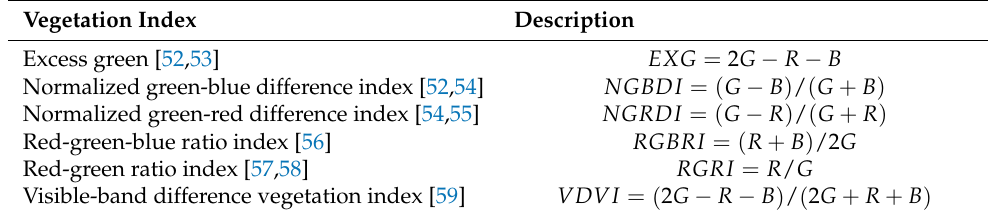
Table 1. A feature space set of vegetation index